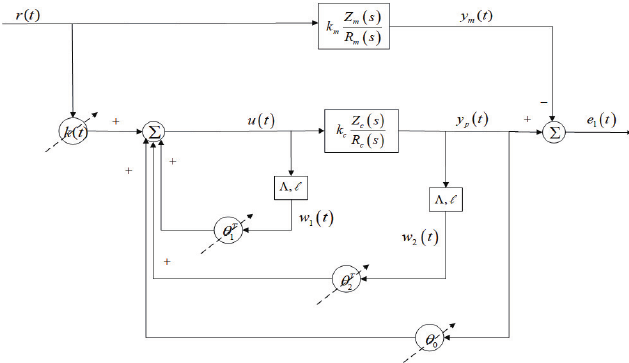
Figure 1. Visualization of the controller